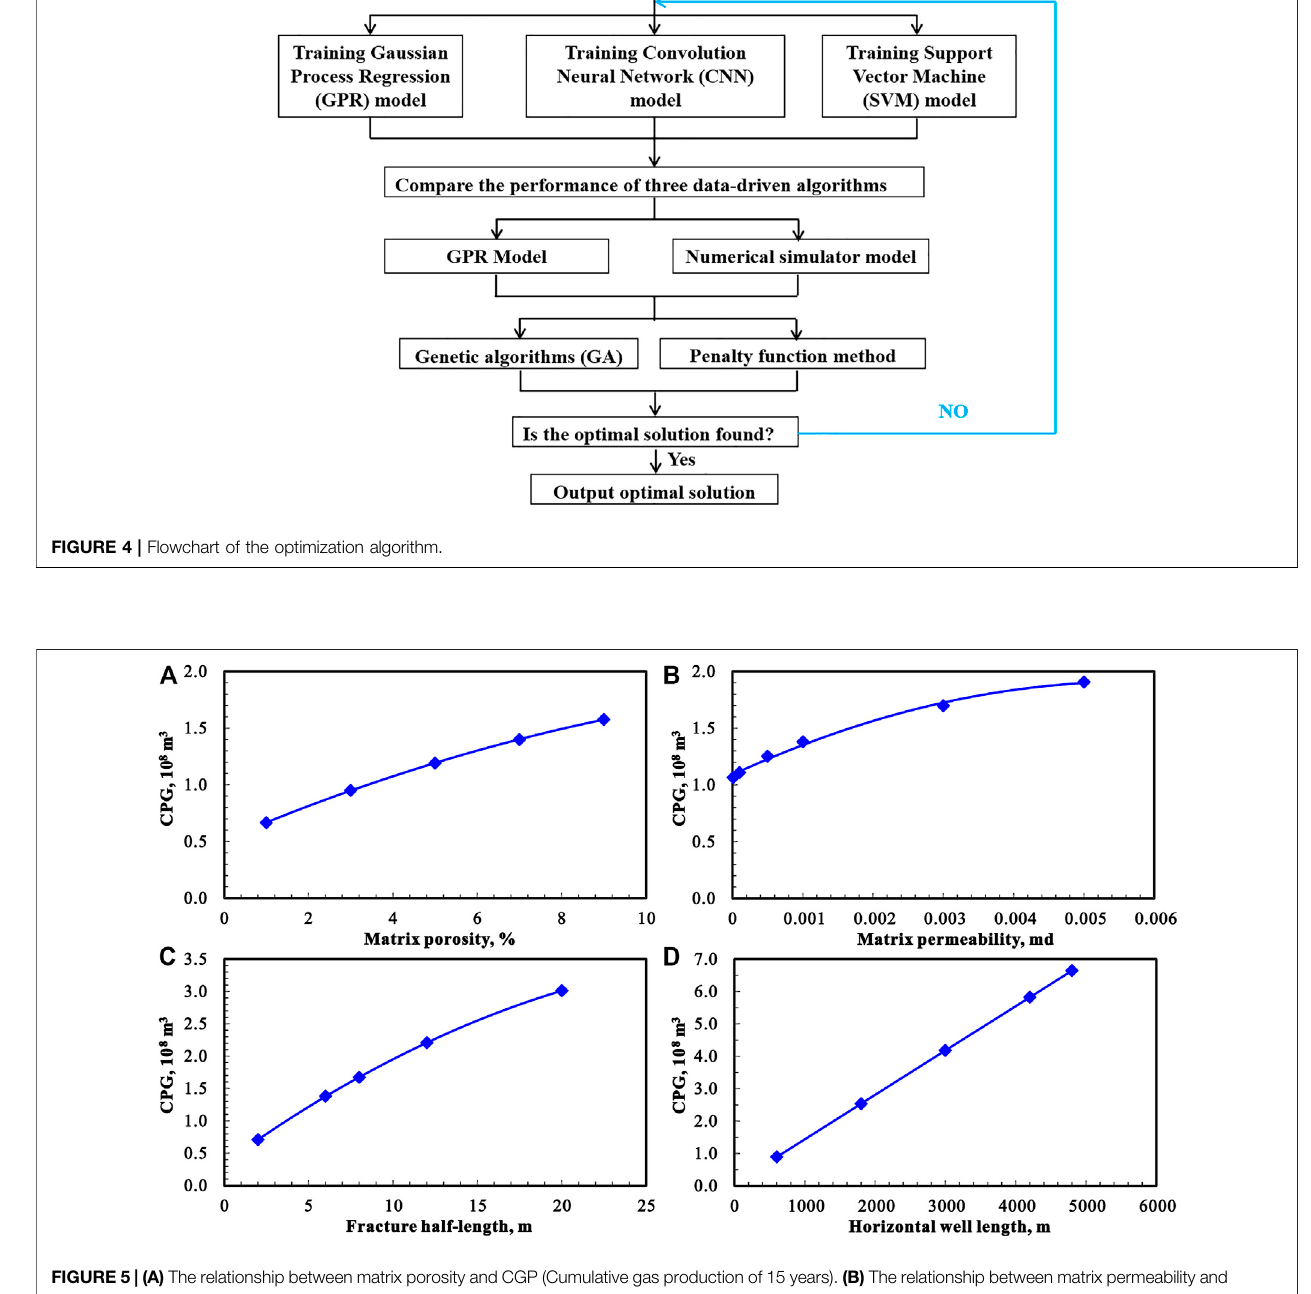
Frontiers in Earth Science |